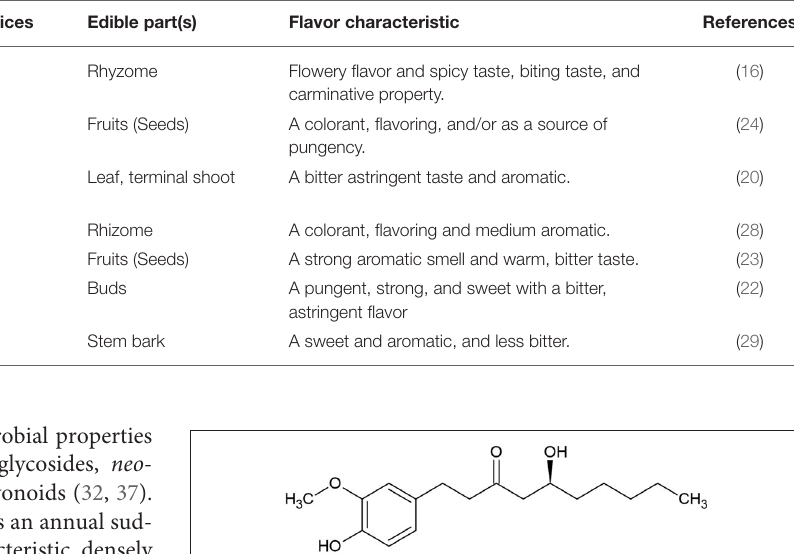
TABLE 1 | Description of spices used in the Mediterranean diet along with their classification and characteristic.